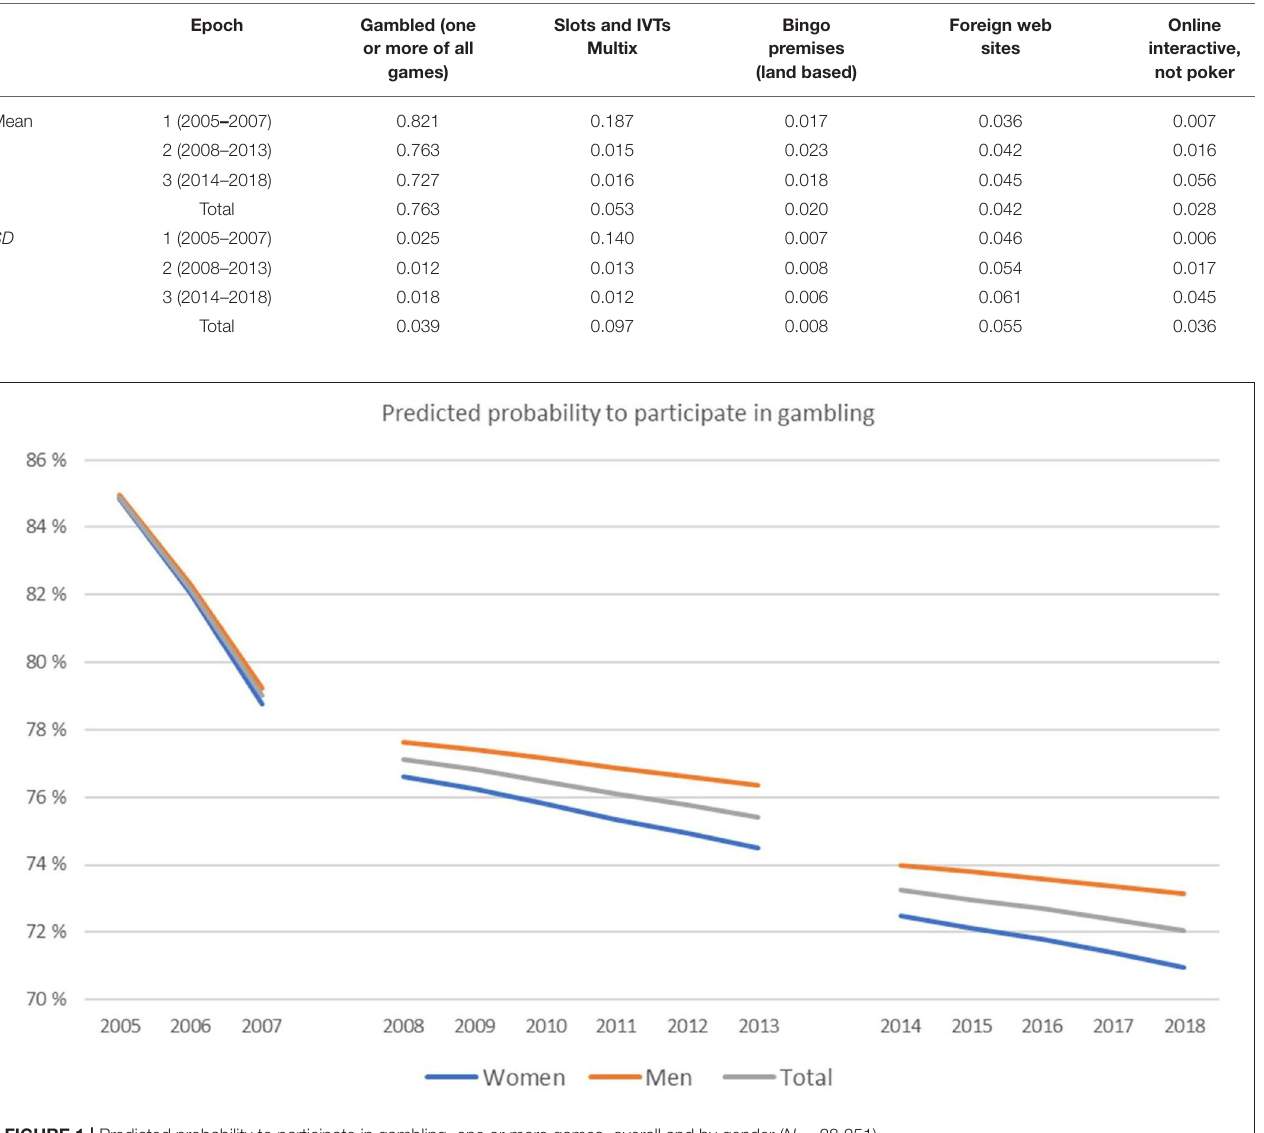
reduction is for land-based slot machines and IVTs Multix.